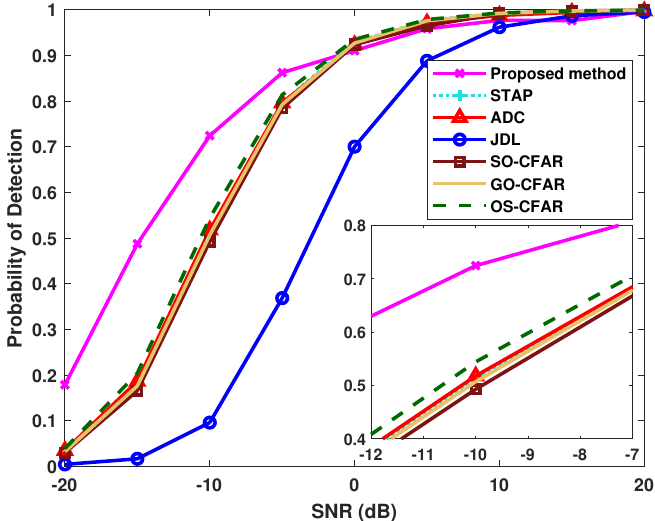
Figure 4. Relationship between PD and SNR. To visually show the target detected by different methods in Figure 4, space-time spectrum distributions without a target and with a target with respect to Figure 4 can be found in the upper subfigures of Figure 5. Additionally, the clutter and target distributions of the spectra corresponding to Figure 1 are also representatively depicted in the lower subfigures of Figure 5. Their respective SNRs are SNR = 20 dB and SNR = 30 dB. From the power spectra, we can analyze that broadened clutter ridges and targets make it difficult to achieve the target detection, especially in the low SNR region. However, in these conditions, the proposed unsupervised algorithm is effective. It performs well and is preferable to the other analyzed methods.